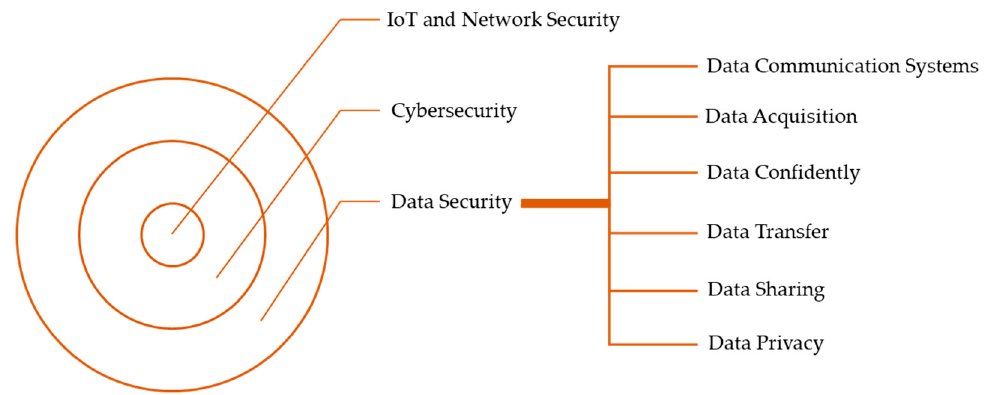
Figure 2. IoT info security: how important is it?